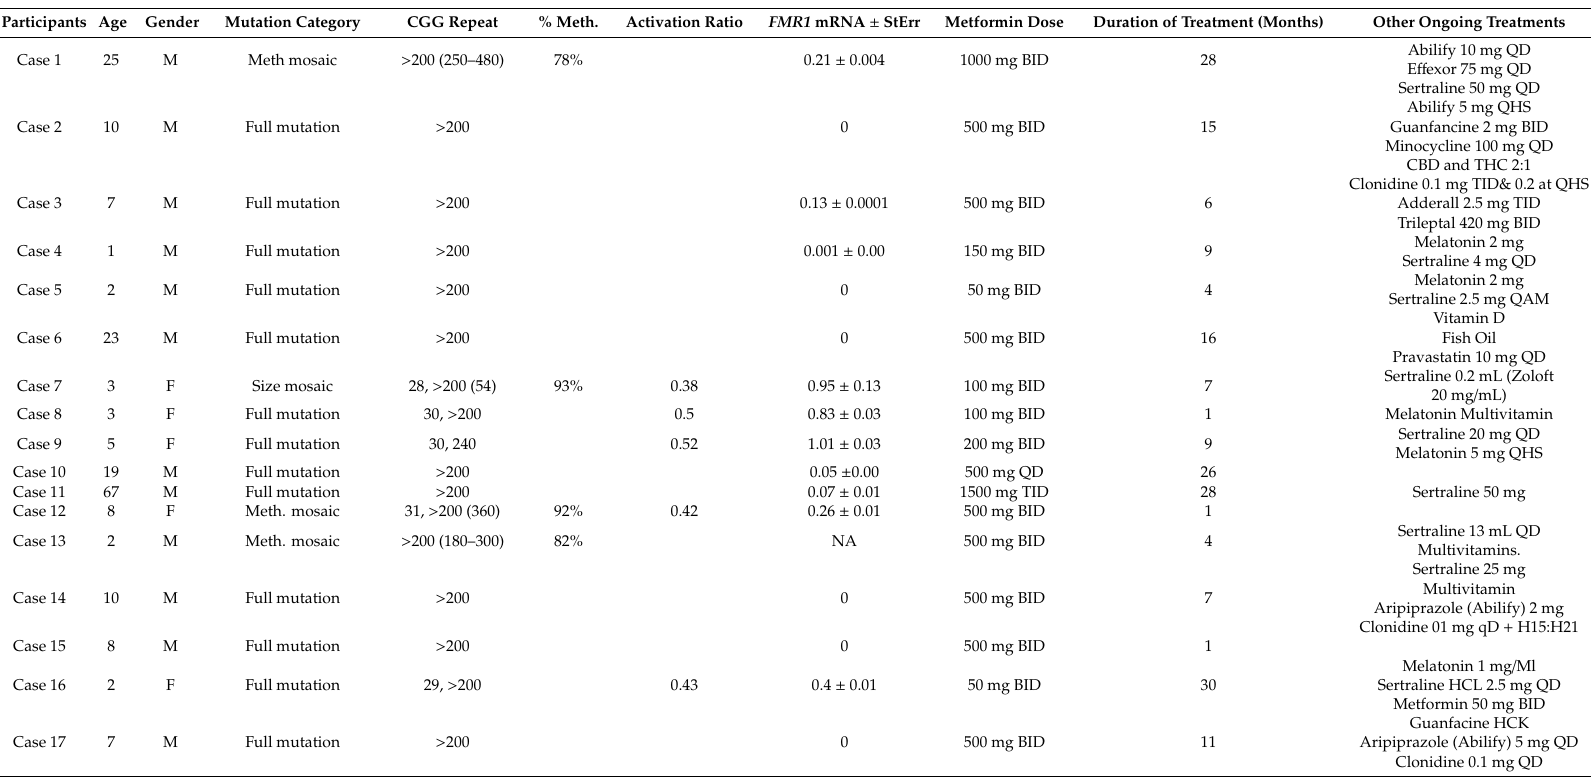
Table 1. Demographic, molecular and medication information for participants included in the study. QD: once a day; BID: twice a day; TID: three times a day; QHS: every night at bedtime; QAM: every